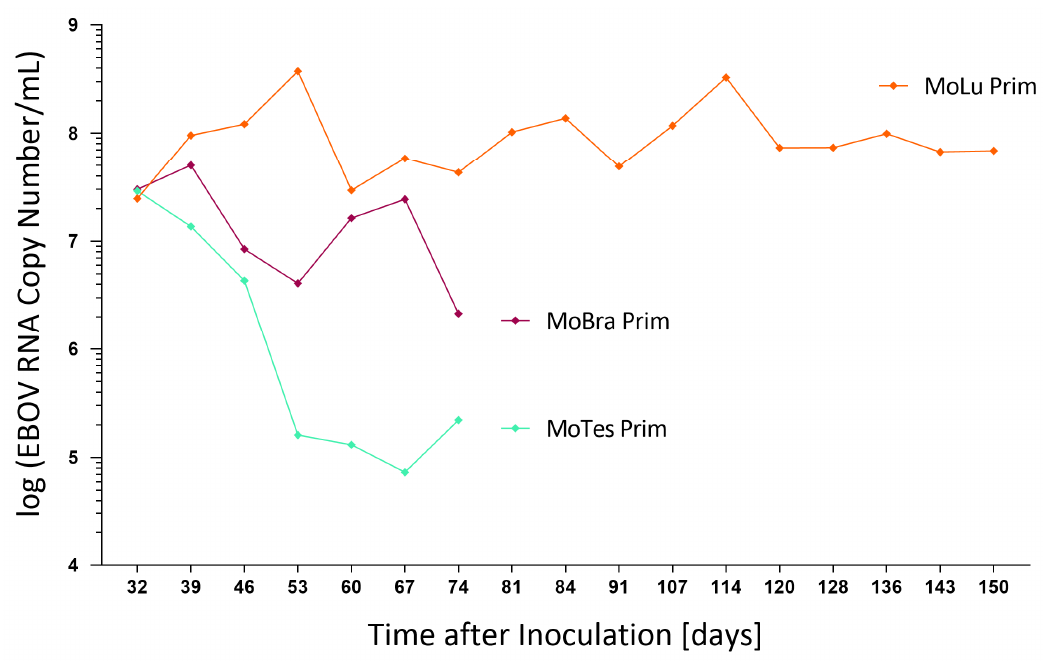
Figure 3. EBOV replication kinetics in long-term infected M. condylurus cells. Viral RNA copy numbers/mL in supernatants Figure 1. This is a figure. Schemes follow the same formatting. 70 of infected cell isolates were determined by qRT-PCR for 74 (purple, cyan) and 150 (orange)